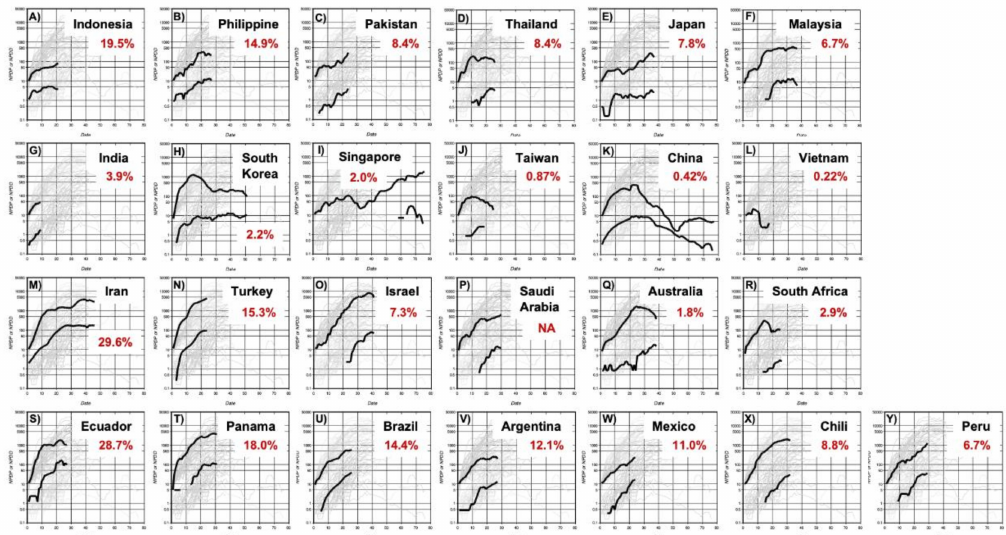
Figure 2. Time courses of NPDP and NPDD by COVID-19 after BPI in Asian countries (Panels ( A – L )), the Middle East (Panels ( M – P )), Oceania (Panel ( Q )), South Africa (Panel ( R )), and Latin America (Panels ( S – Y ). Numbers in red represent the positive rate of the PCR test. The countries are placed in decreasing order of the positive rate in each region. The upper and lower bold lines in each panel are NPDP and NPDD, respectively, except for Vietnam where no death has been recorded. The scales in all panels are the same as those in Figure 1. *: Positive rate in Guangdong. NA: Not available. NPDP: number of population-adjusted daily test-positive cases. NPDD: number of population-adjusted daily deaths. BPI: beginning of the test-positive cases increase.